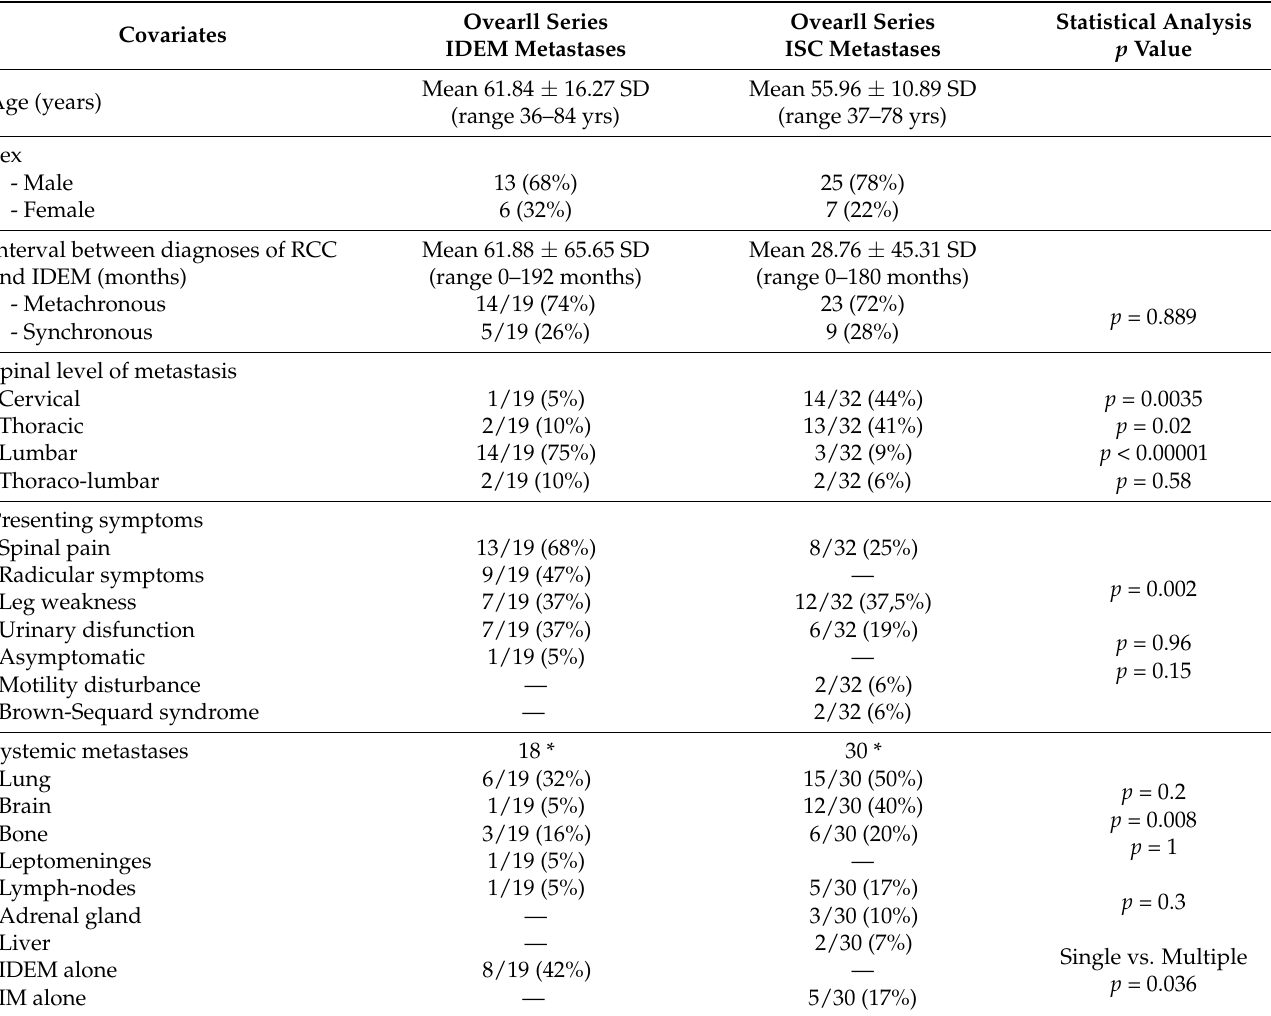
Table 2. Demographic, clinical, pathological, management and outcome data of 51 cases of spinal intradural metastasis from